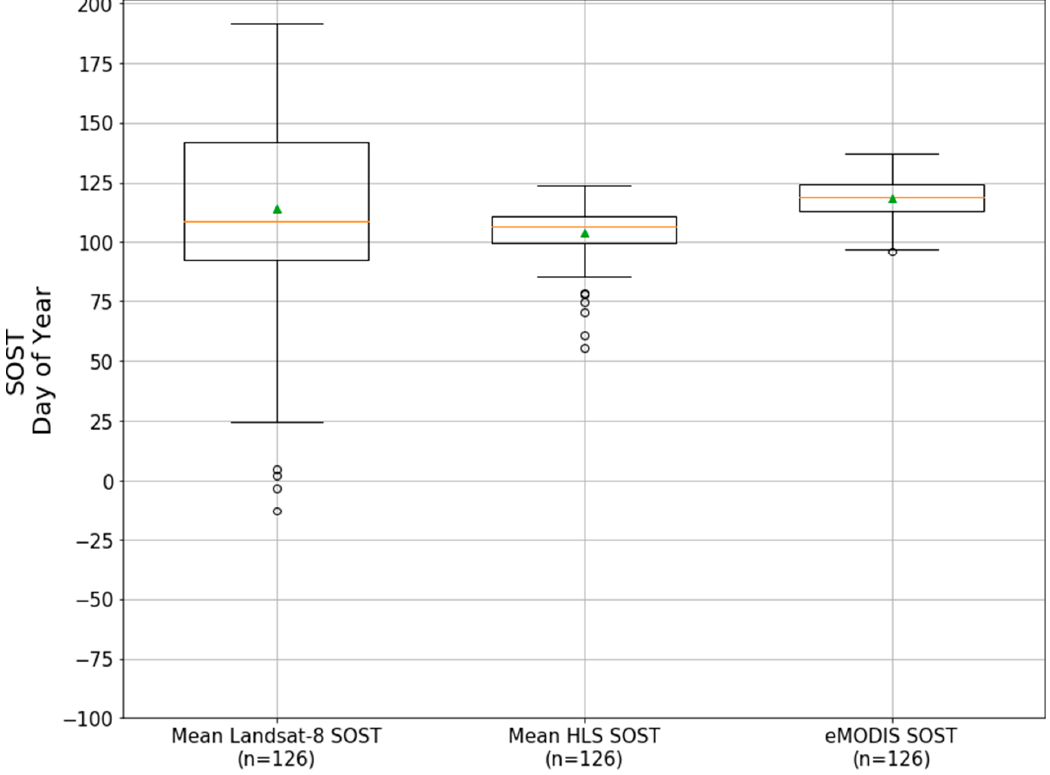
Figure 5. The distribution of grassland SOST results calculated from time series Landsat-8, HLS, and eMODIS data. Yellow lines show the median grassland SOST; green triangles show the average grassland SOST; and the box extents show the lower to upper quartile values of the grassland SOST. The value n indicates the number of grassland pixels at the eMODIS scale.